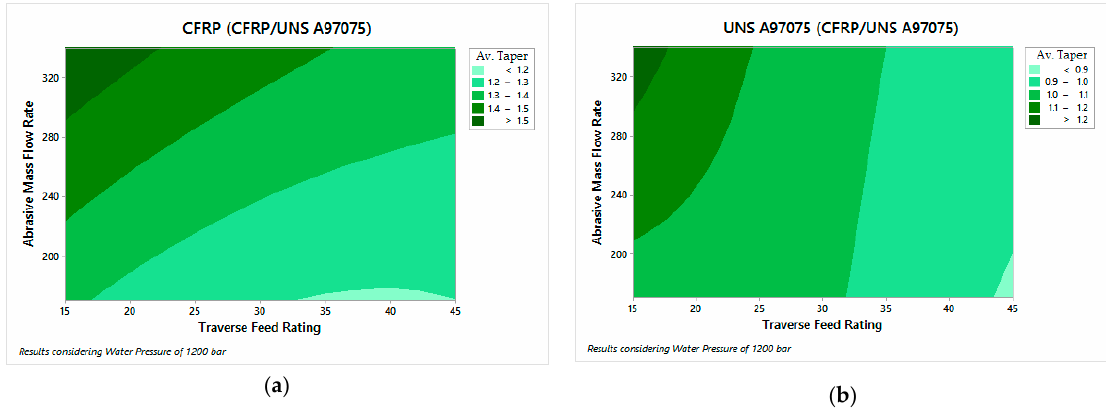
Figure 11. Average kerf taper for CFRP/USN A97075/ configuration: ( a ) CFRP; ( b ) UNS A97075.